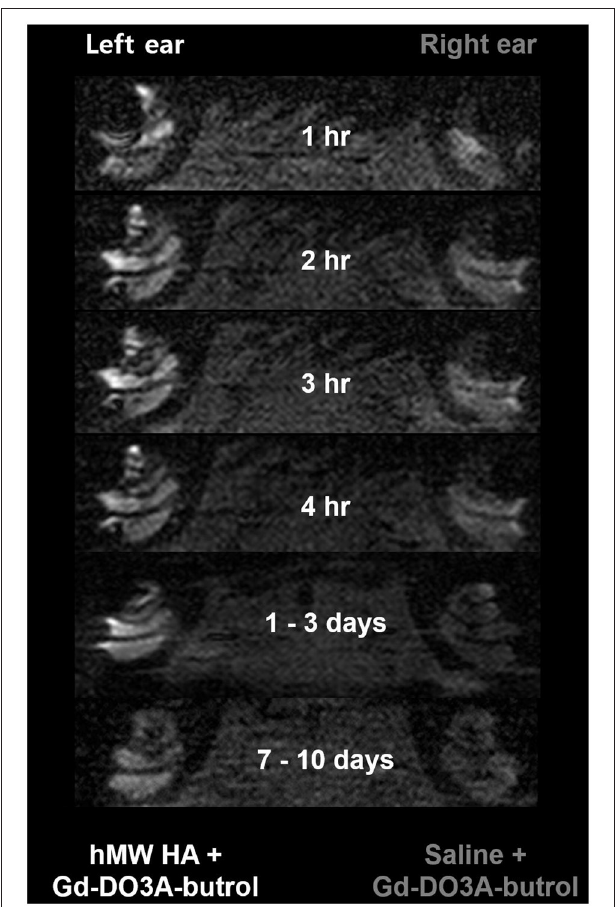
FIGURE 4 | Long-term cochlear enhancement patterns after intratympanic (IT) gadolinium (Gd) injection with two different vehicles. Gd-DO3A-butrol was delivered using a high-molecular-weight (hMW) hyaluronic acid (HA) vehicle in the left ear and saline in the right ear. Qualitatively, the left cochlea, which was treated with Gd loaded in hMW HA, was brighter than the contralateral